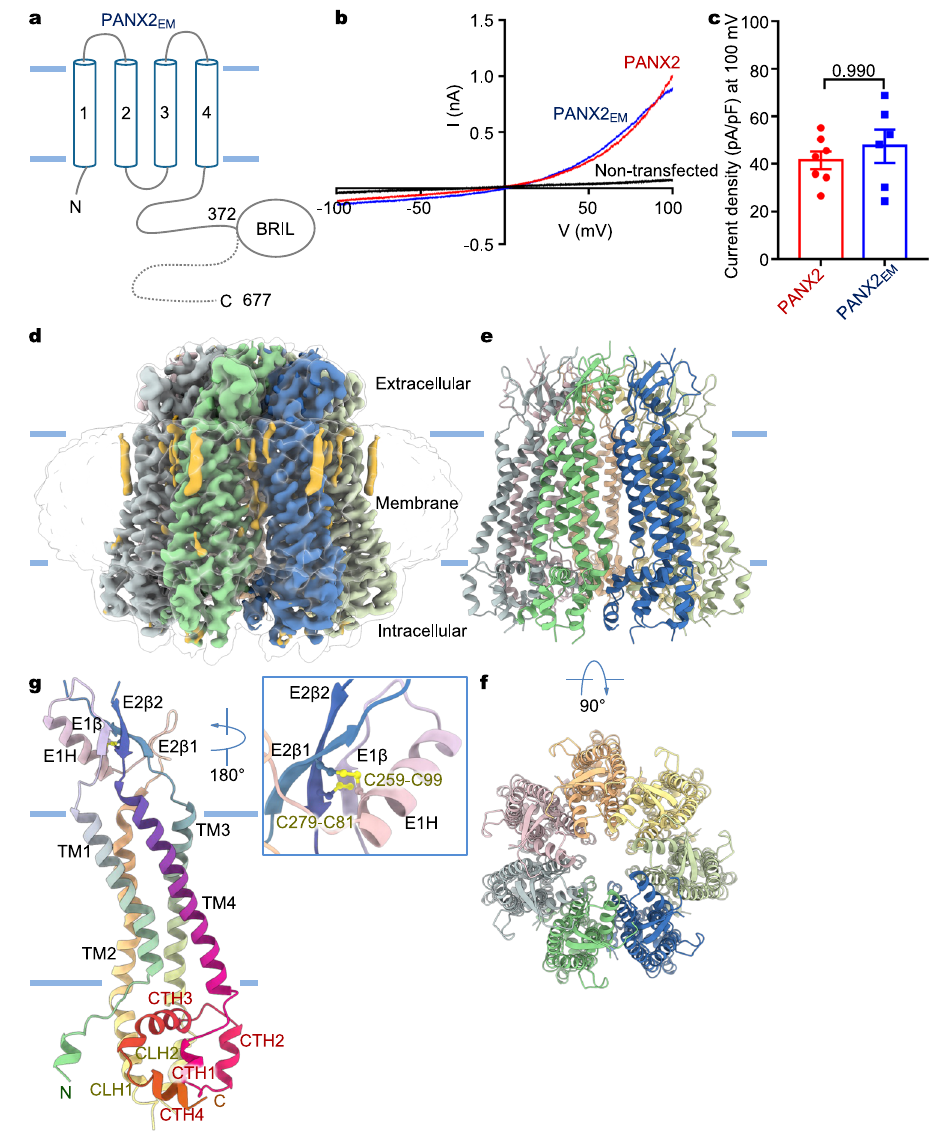
Fig. 1 | Structure of human PANX2. a Domain topology of human PANX2. The engineered protein construct PANX2 EM for structure determination is indicated. b Current – voltagecurves forthewild-typefull-lengthhumanPANX2andPANX2 EM expressed in HEK293T cells. Currents from untransfected cells were used as the negative control. c Current density for the full-length and PANX2 EM . Data are pre- sented as mean±SEM. p -value is indicated (unpaired two-tailed t -test, n =7, 6